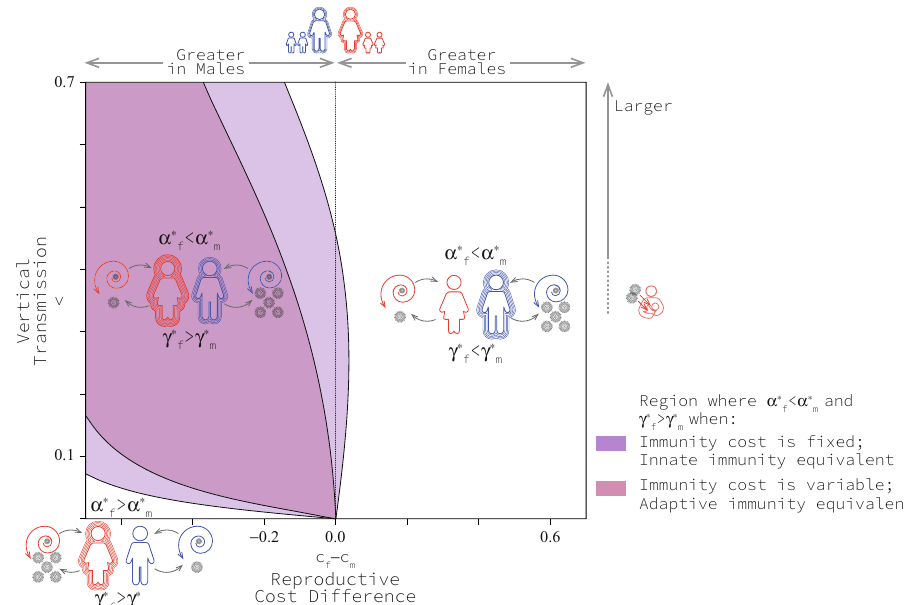
Fig. 5 | Regions of qualitatively different co-evolutionary patterns when the fi tness cost of immune investment is fi xed and variable. Fixed immunity costs arethoseexperiencedinallcases(withorwithoutinfection)andbestre fl ectinnate immunitycosts.Variableimmunitycostsarethoseexperiencedwithinfectiononly